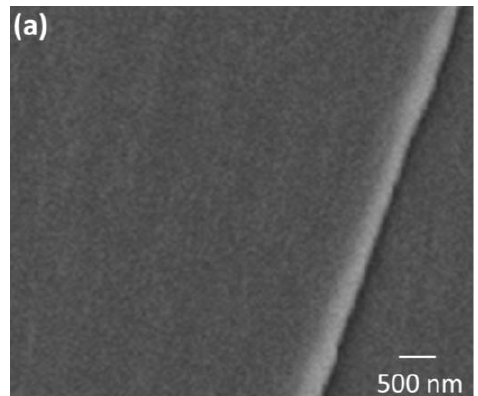
Figure 13. Scanning Electron Micrographs showing the ‗mirror‘ zone on tensile fracture surfaces of ( a ) neat epoxy; ( b ), ( d ) 0.3 vol% of 20k20k-SiO nanocomposites; ( c ), ( e ) 2 1 vol% of 20k20k-SiO nanocomposites; ( f ), ( h ) 0.1 vol% 40k40k-SiO nanocomposites; 2 2 and ( g ), ( i ) 0.2 vol% of 40k40k-SiO 2